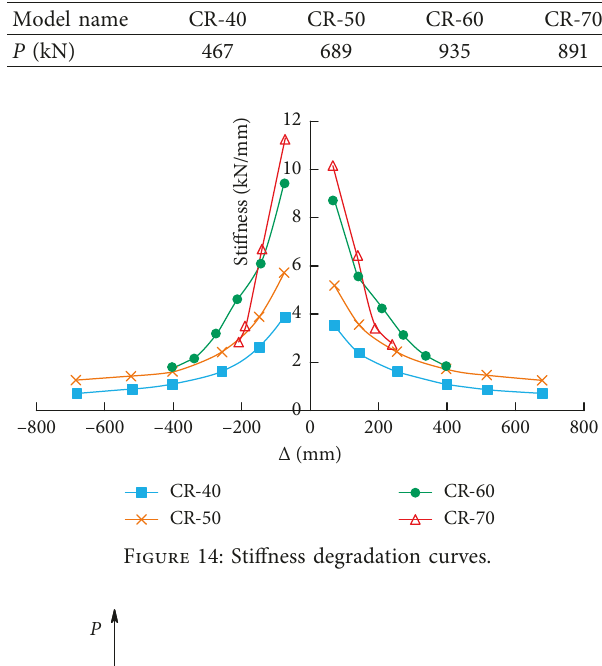
Figure 13: Skeleton curve of the models. Table 4: Ultimate load-carrying capacity of the models.